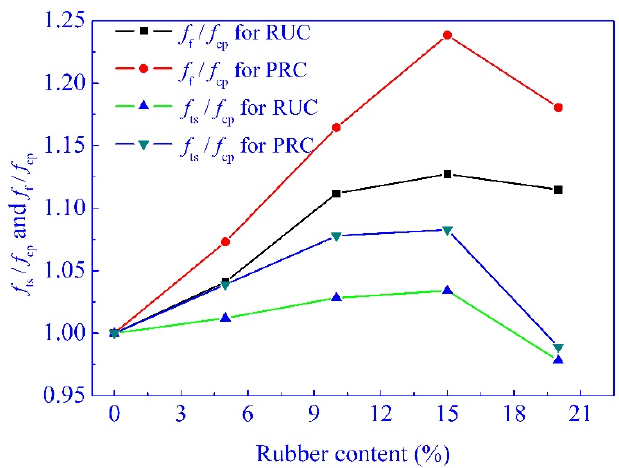
Figure 5. f ts / f cp and f f / f cp of rubberized concrete.